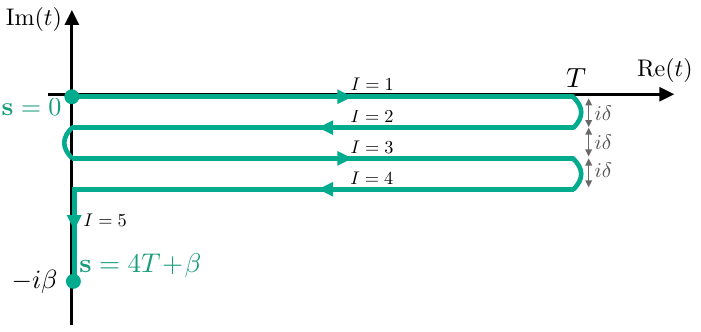
Figure 1 . Generalized Schwinger-Keldysh contour C for the path integral calculation of the out- of-time-order correlators. The integration contour in the complex t plane is parametrized by the real-valued contour time s ∈ [0 , 4 T + β ] . Infinitesimal contour separations by iδ serve as a regulator (which we only keep track of when it is needed for